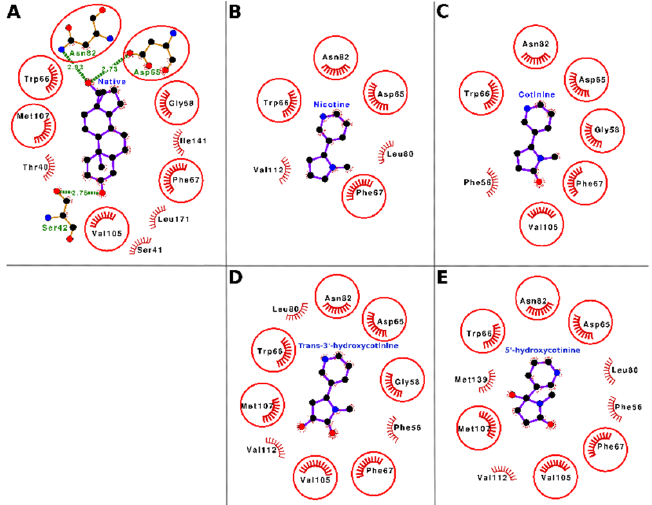
Figure 4. Ligand–protein interaction plots of the native ligand (dihydrotestosterone; Panel A ), nicotine (Panel B ), cotinine (Panel C ), trans-3 ′ -hydroxycotinine (Panel D ), and 5 ′ -hydroxycotinine (Panel E ) in complex with sex-hormone-binding globulin (SHBG). The ligands are placed at the center of each plot surrounded by the interacting residues. The ligands and the residues forming hydrogen bonds are shown in the ball and stick representation. The balls represent the atoms, and the sticks represent the bond between them. The color of the balls differentiates the atom types, i.e., the black balls represent carbon atoms, red balls oxygen atoms, and blue balls nitrogen atoms. The hydrogen bonds are shown as green dashed lines labeled with bond length (in Å). The residues forming nonbonded contacts are shown as arcs with bristles. The interacting residues for ligands which are common with the interacting residues for the native ligand are encircled.